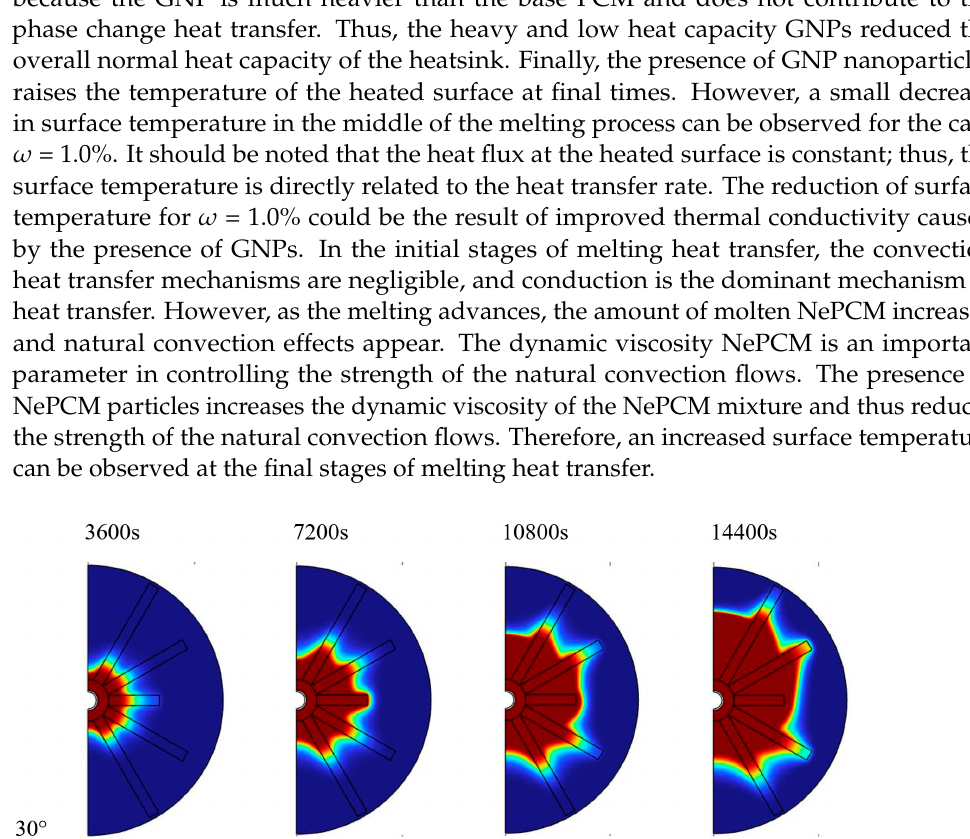
Figure 8. The temperature difference distribution (°C), T − T f , maps at different time steps for two cases of δ = 30° and δ = 37.5° when ε = 0.95 and ω = 1% wt.